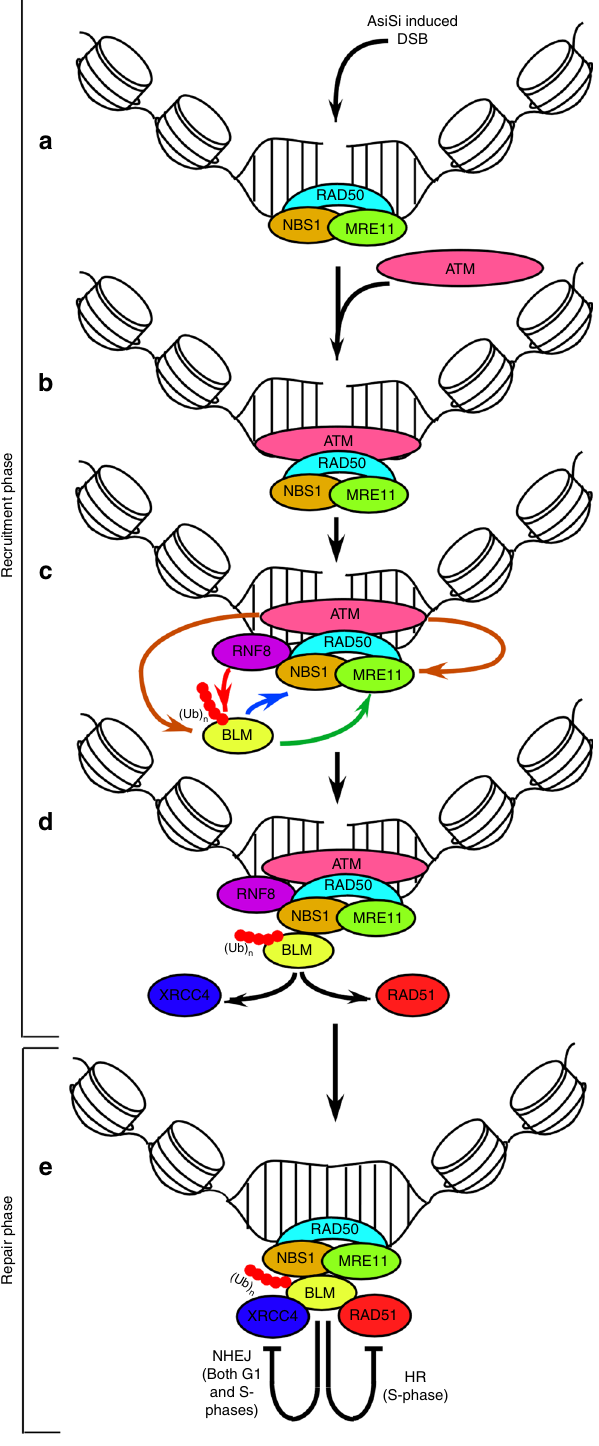
regulatory protein (due to its role in the repair phase), thereby maintaining genomic